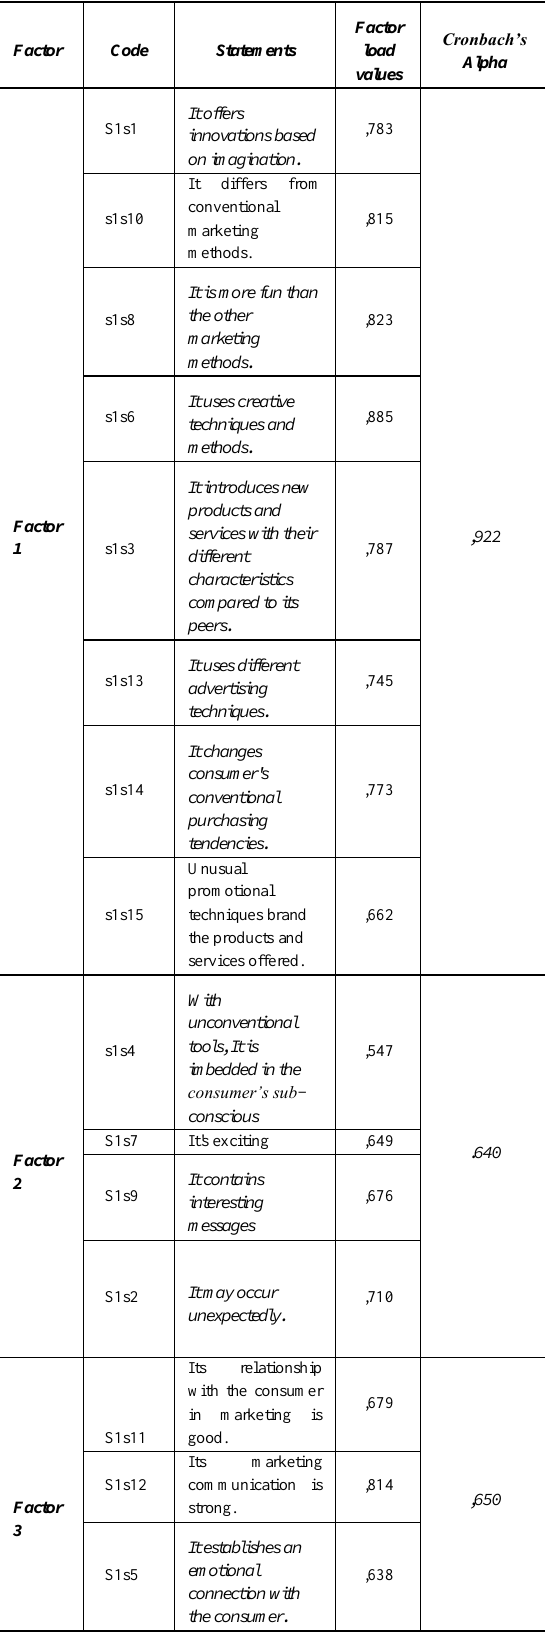
Table 4: Exploratory Factor and Reliability Analyses Results of the Scale of Consumer Perception on Guerrilla Marketing Methods